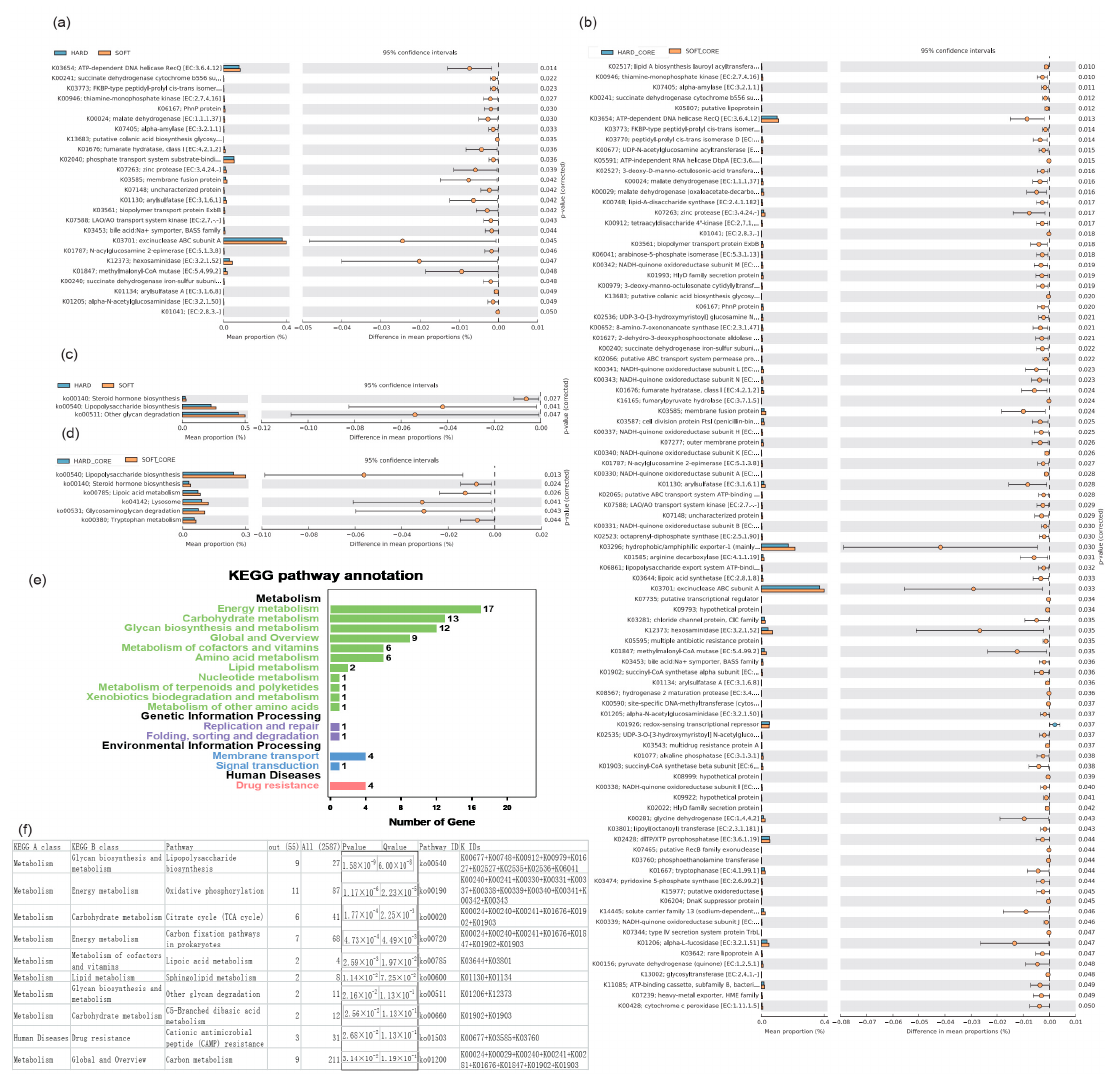
Figure 5. Significantly different KEGG functional pathways. The significance was measured in STAMP v2.1.3 using White’s nonparametric test ( p < 0.05). ( a ) K-numbers based on the total OTUs. ( b ) K-numbers based on the core OTUs. ( c ) KEGG pathways based on the total OTUs. ( d ) KEGG pathways based on the core OTUs. ( e ) Annotated KEGG pathways based on the K-numbers of core OTUs. ( f ) Enrichment analysis based on the K-numbers of core OTUs ( p < 0.05).